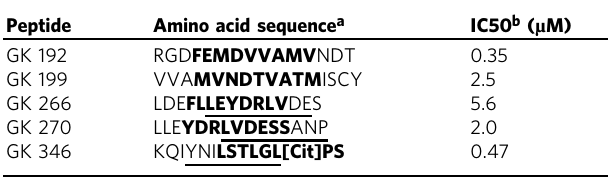
(DQ2) , confer high risk with about 80-90% of T1D patients